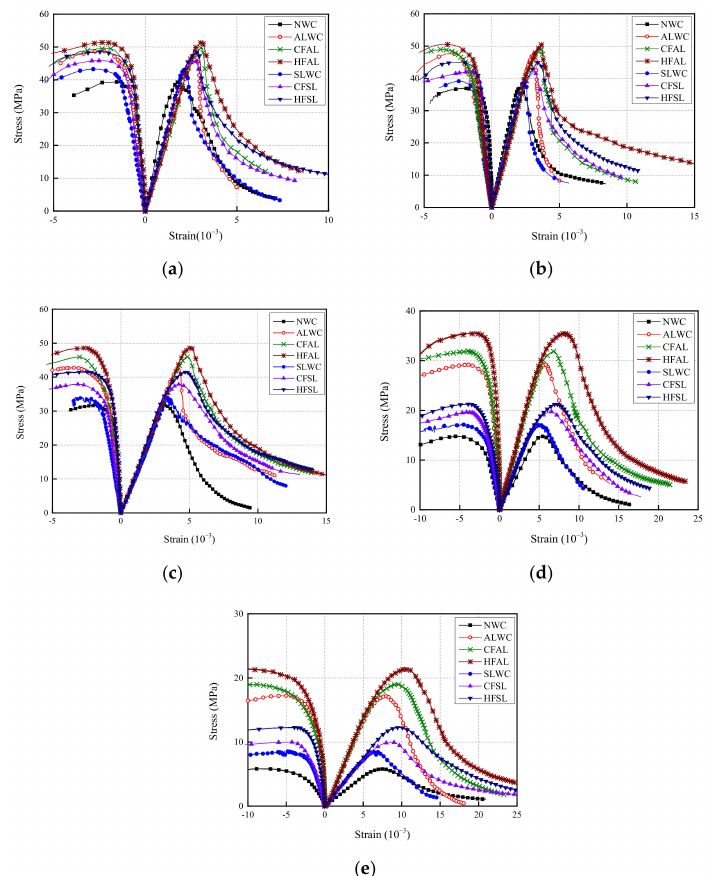
Figure 9. Stress–axial strain curves of all mixes exposed to elevated temperatures: ( a ) 25 ◦ C; ( b ) 200 ◦ C; ( c ) 400 ◦ C; ( d ) 600 ◦ C; ( e ) 800 ◦